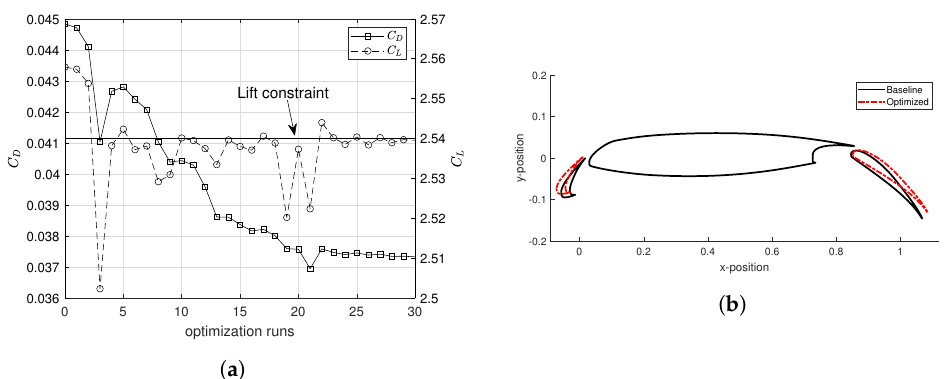
Figure 14. Optimisation of position and orientation of the slat and flap. ( a ) Coefficient of drag and lift. ( b ) Baseline and optimised designs.